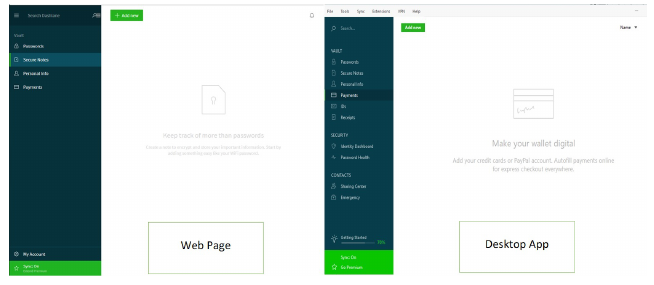
Figure A18. Colour of application and webpage of Dashlane.